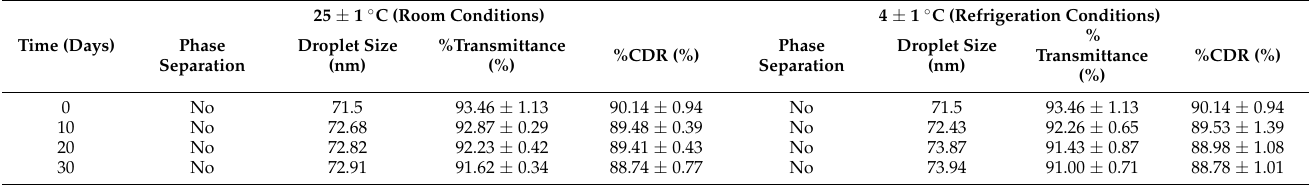
Table 5. Data of stability studies for optimized AZL-NE